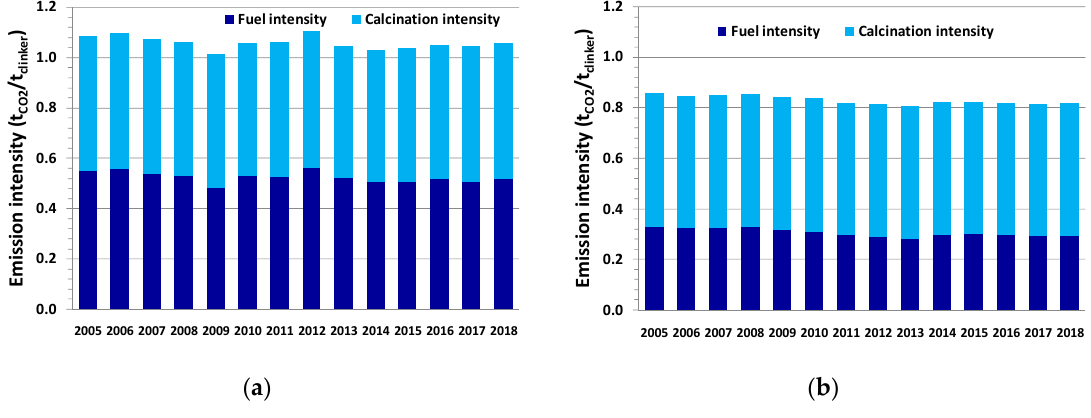
Figure 1. Carbon dioxide emission intensity in the Spanish cement industry from 2005 to 2018: ( a ) for white clinker; ( b ) for gray clinker.